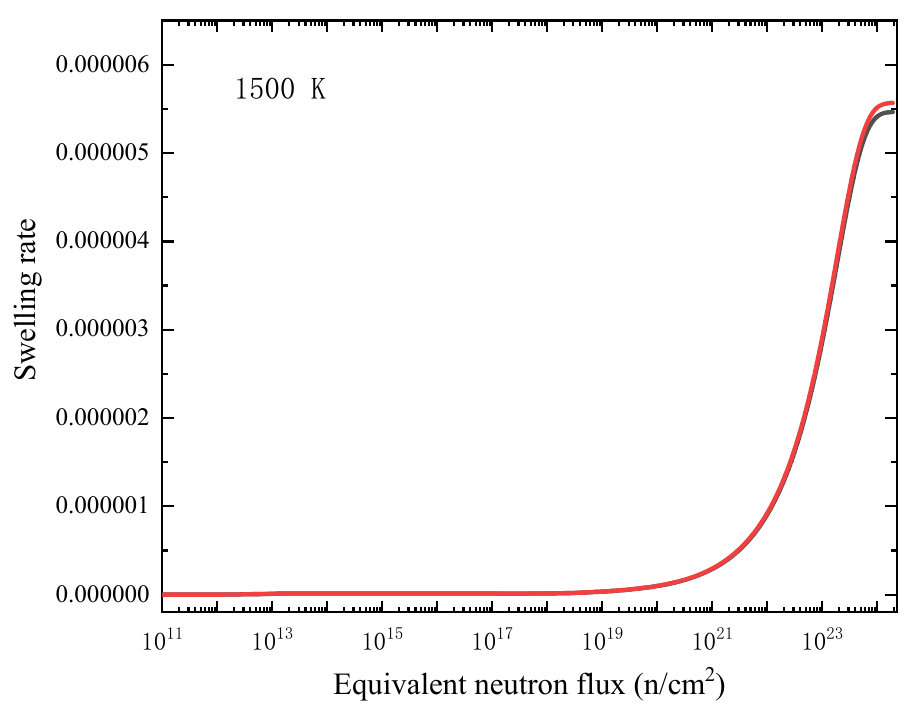
Figure 8. Relationship between swelling rate and equivalent neutron flux (1 MeV) in the central region of SiC film at 600 K. Black line corresponds the calculations with excess volumes from small- size (10 a × 10 a × 10 a ) supercell simulations and the red line corresponds the calculations with excess volumes from large-size (20 a × 20 a × 20 a ) supercell simulations.